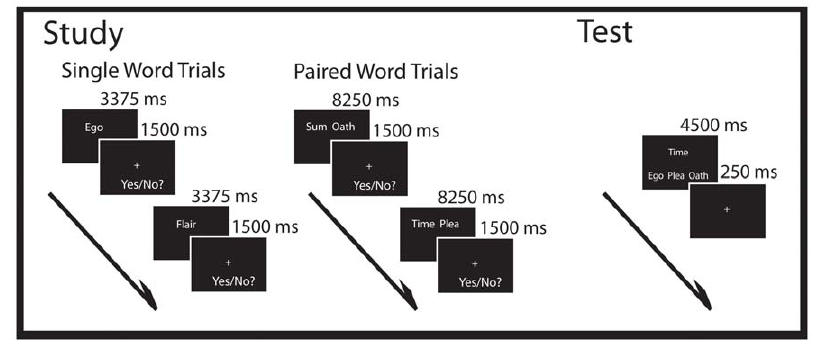
Figure 1. Trial schematic for the study and test phases respectively.